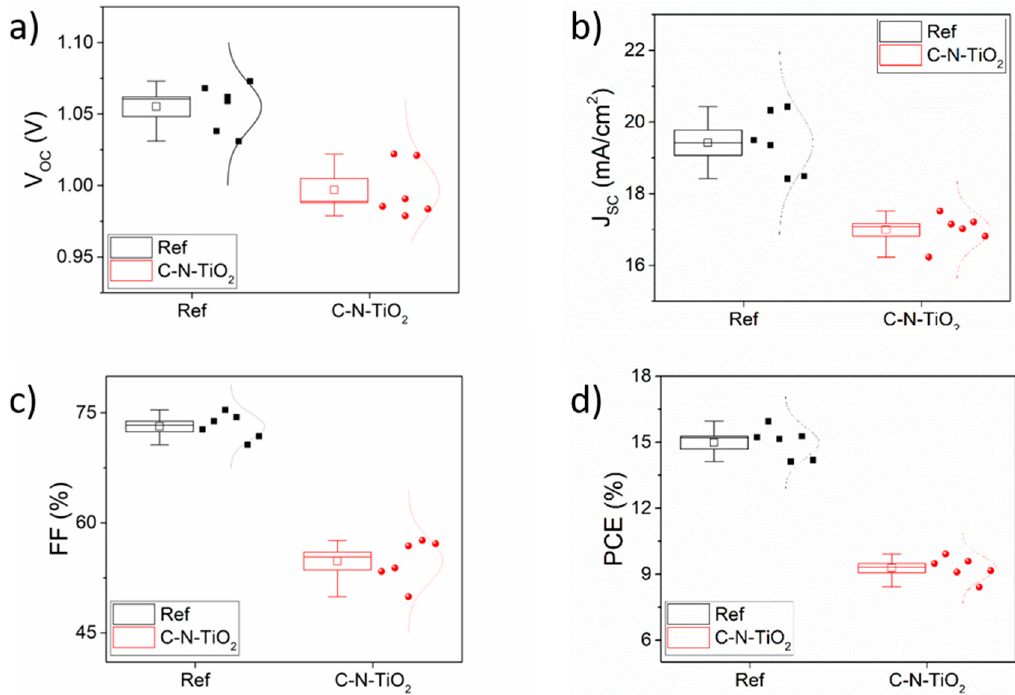
Figure 12. Photovoltaic Figures of Merit (FoM) of reference perovskite solar cells (PSCs) and C-N-TiO 2 -based devices extracted from the current-voltage ( I - V ) characteristics measured under one-sun (1 SUN) illumination: ( a ) open-circuit voltage ( V OC ); ( b ) short-circuit current density ( J SC ); ( c ) fill factor (FF); and ( d ) power conversion efficiency (PCE). The relative standard error reported as error bar is extracted by measuring six devices.